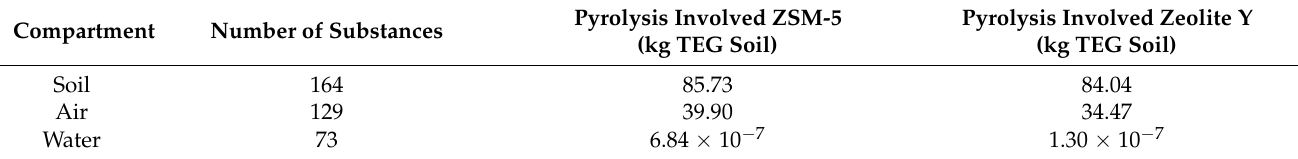
Table 7. The number and value of the substance’s emission in two scenarios.